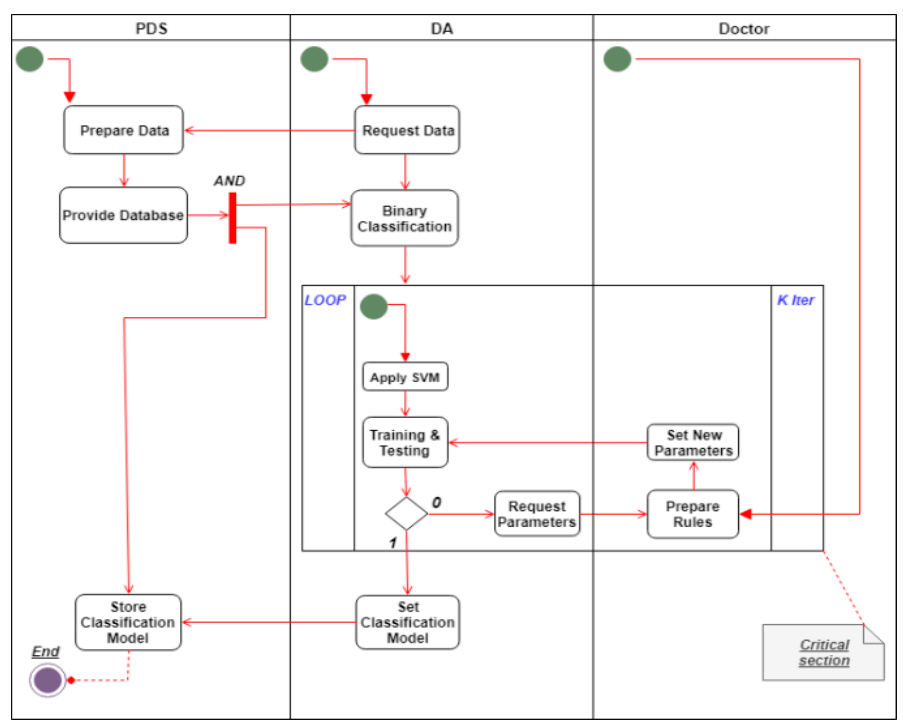
Figure 4. Use case diagram for the SSS .